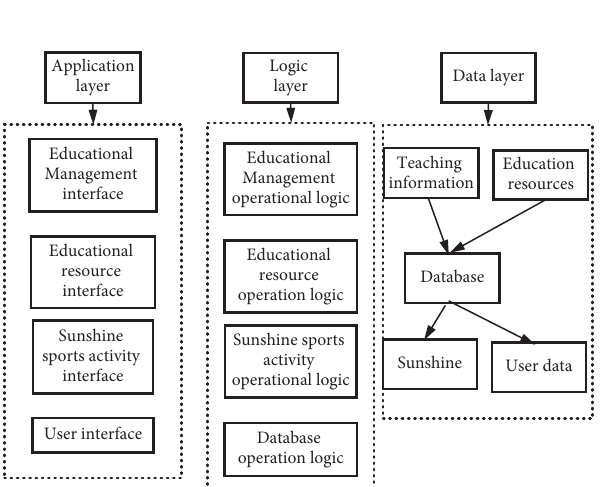
Figure 2: Overall structure diagram of college sports information teaching platform.